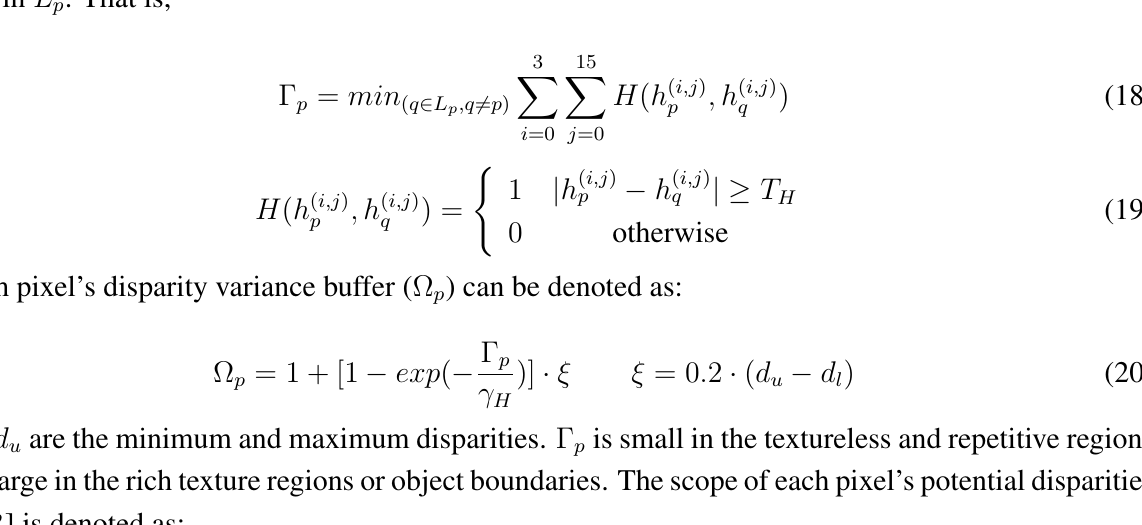
, for: ( a ) pixel p and ( b ) its corresponding p